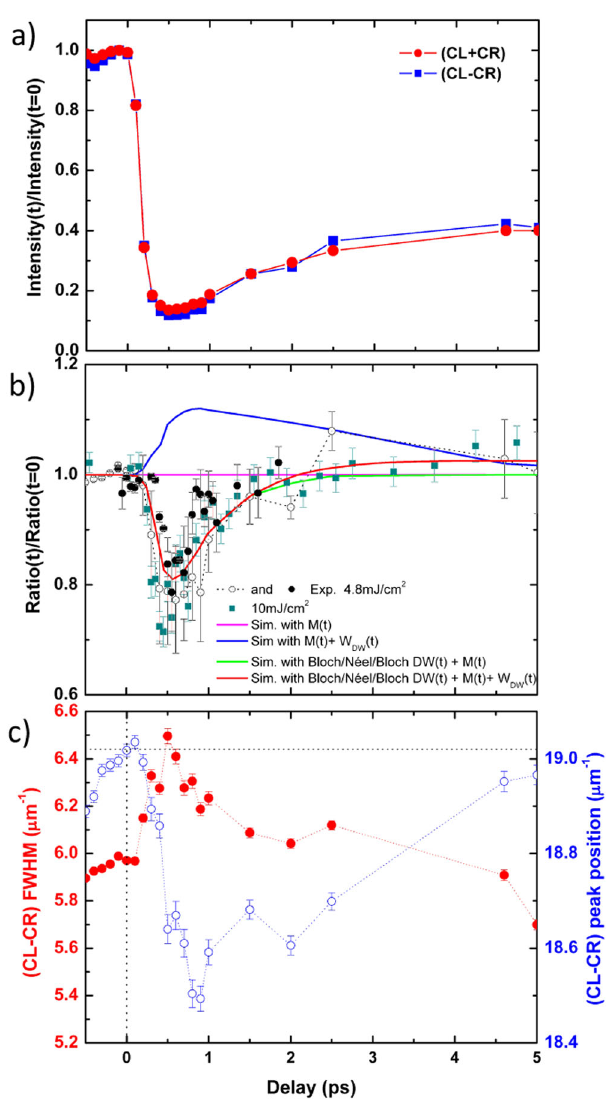
Fig. 2 Evolution of the XRMS signal over the fi rst 5 ps. a Intensity of integrated diffraction ring (CL + CR) and dichroism (CL-CR) normalized at their values at negative time delays; b experimental asymmetry ratio (CL- CR)/(CL + CR) normalized by its value at t < 0 in grey circles, black dots (4.8 mJ/cm 2 IR fl uence) and dark cyan square (10 mJ/cm 2 IR fl uence). The simulations for different models discussed in the main text appear as colored lines (see Supplementary Materials S3 for details). c Full width at half maximum (FWHM) (red dots) and the position (blue circles) in reciprocal space of the magnetic dichroic peak as a function of